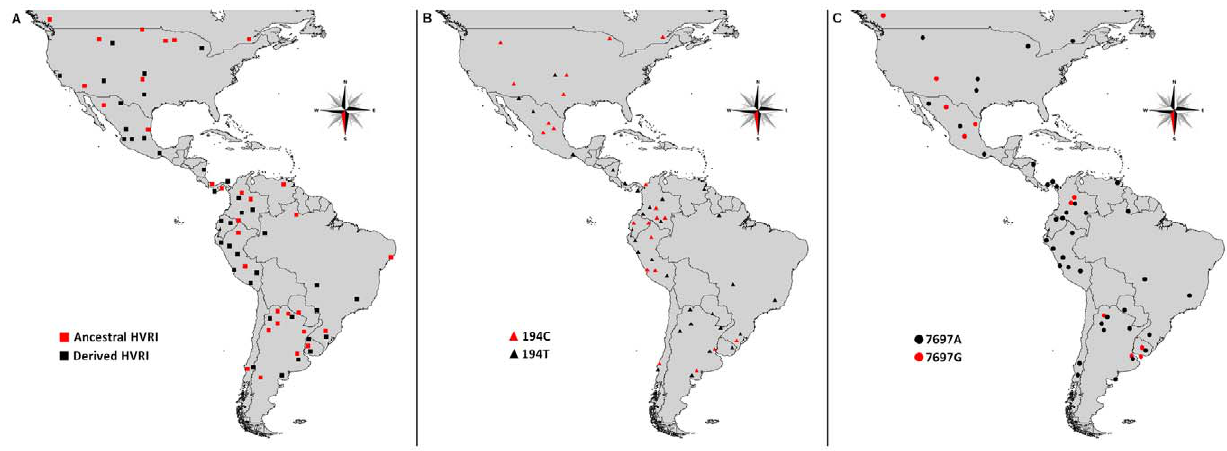
Figure 4. Distribution of C1d lineages in the Americas. A: Distribution of the ancestral and derived lineages as defined using HVR-I only. B: Distribution of lineages carrying the 194C and 194T alleles. C: Distribution of lineages with and without the 7697G R A mutation.